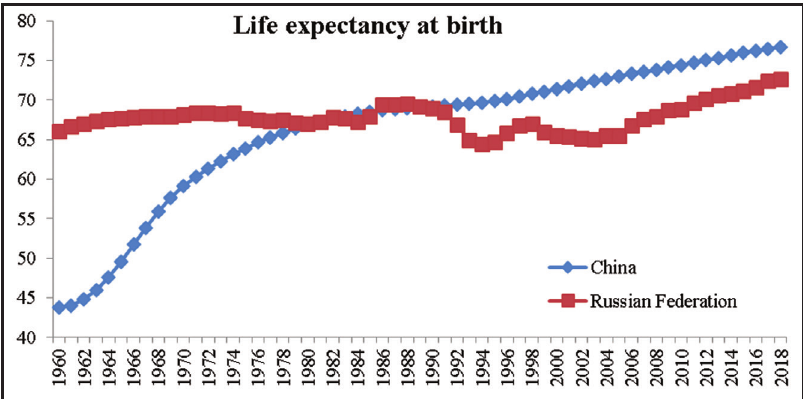
Figure 3 Life expectancy at birth in China and Russia,